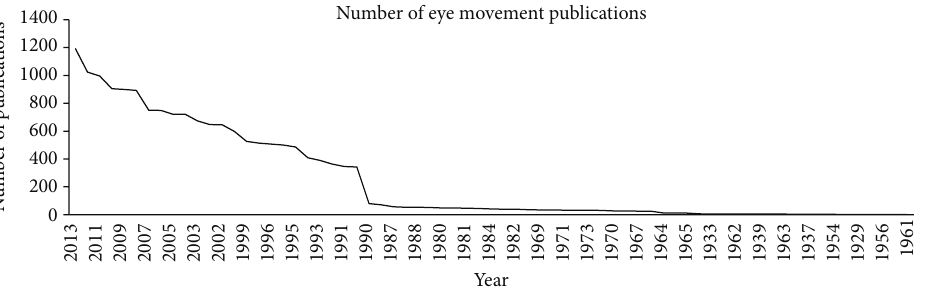
Figure 1: The number of publications with the “eye movement” in the title or abstract, according to a Web of Science search 2014.